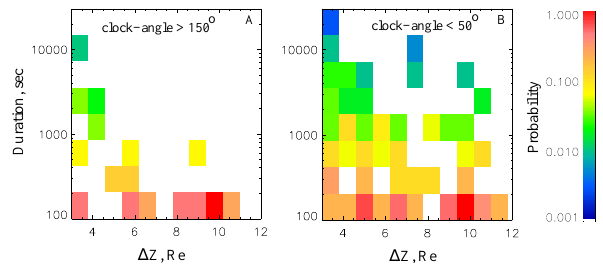
Fig. 14. The duration of PS-like events versus 1Z . The color-coded histogram shows the probability of observing the event of a partic- ular duration at the particular 1Z . Panel (a) shows distribution for southward IMF and panel (b) shows the same for northward IMF.